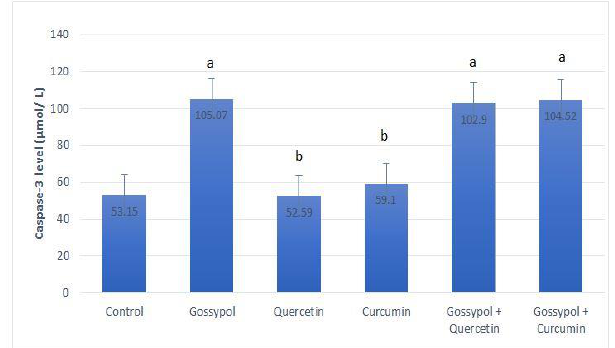
Fig. 2: The effect of treatment with gossypol, quercetin, curcumin, gossypol + quercetin and gossypol + curcumin on Caspase-3 level in ovarian tissue (mean ± standard error). Similar letters indicate no significant differences between groups at (P > 0.05), while different letters indicate a significant difference between groups at (P < 0.05).